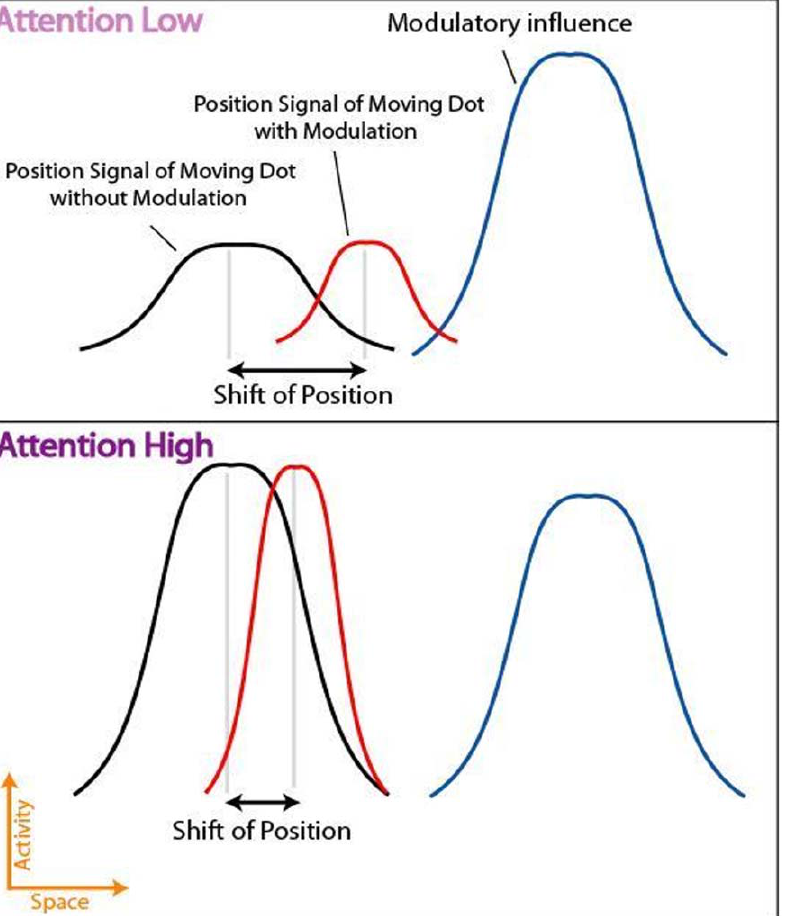
Figure 7. The un-modulated position signal, modulatory influence and position signal after modulation. Two attentional conditions are illustrated: low attention and high attention. When the level of attention directed towards a moving dot is low (upper plot) the dot’s position signal will be weak and spread out, and it will be more prone to perceptual shifts in position due to modulation. In the case where the level of attention directed at a moving dot is high (lower plot), the position signal is stronger, with less spread, which will make it more immune to perceived position- shifts.